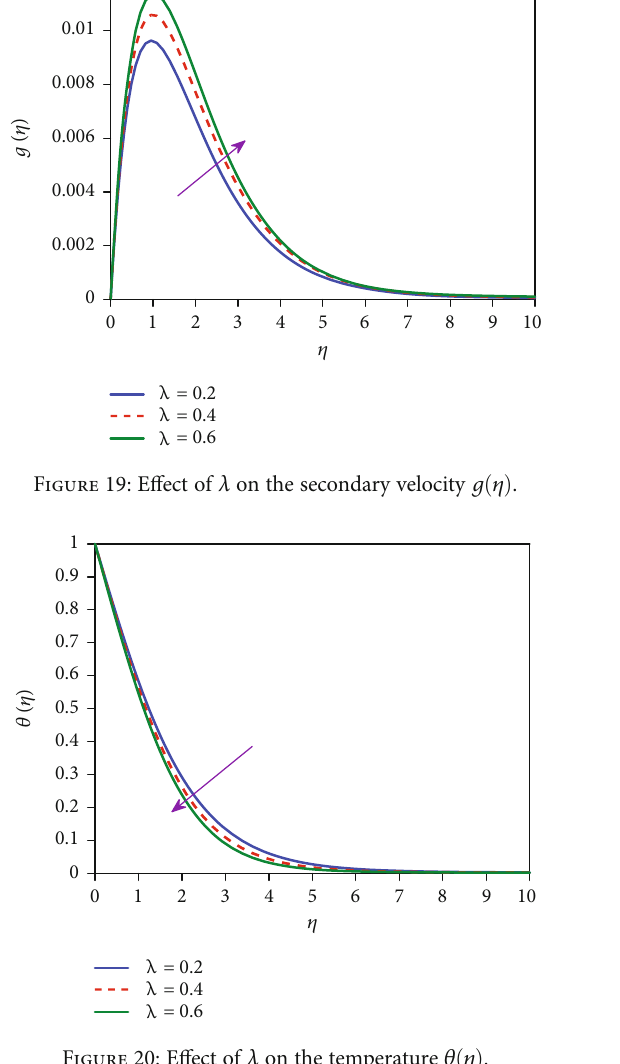
Figure 22: E ff ect of K on the primary velocity f ′ ð η Þ .